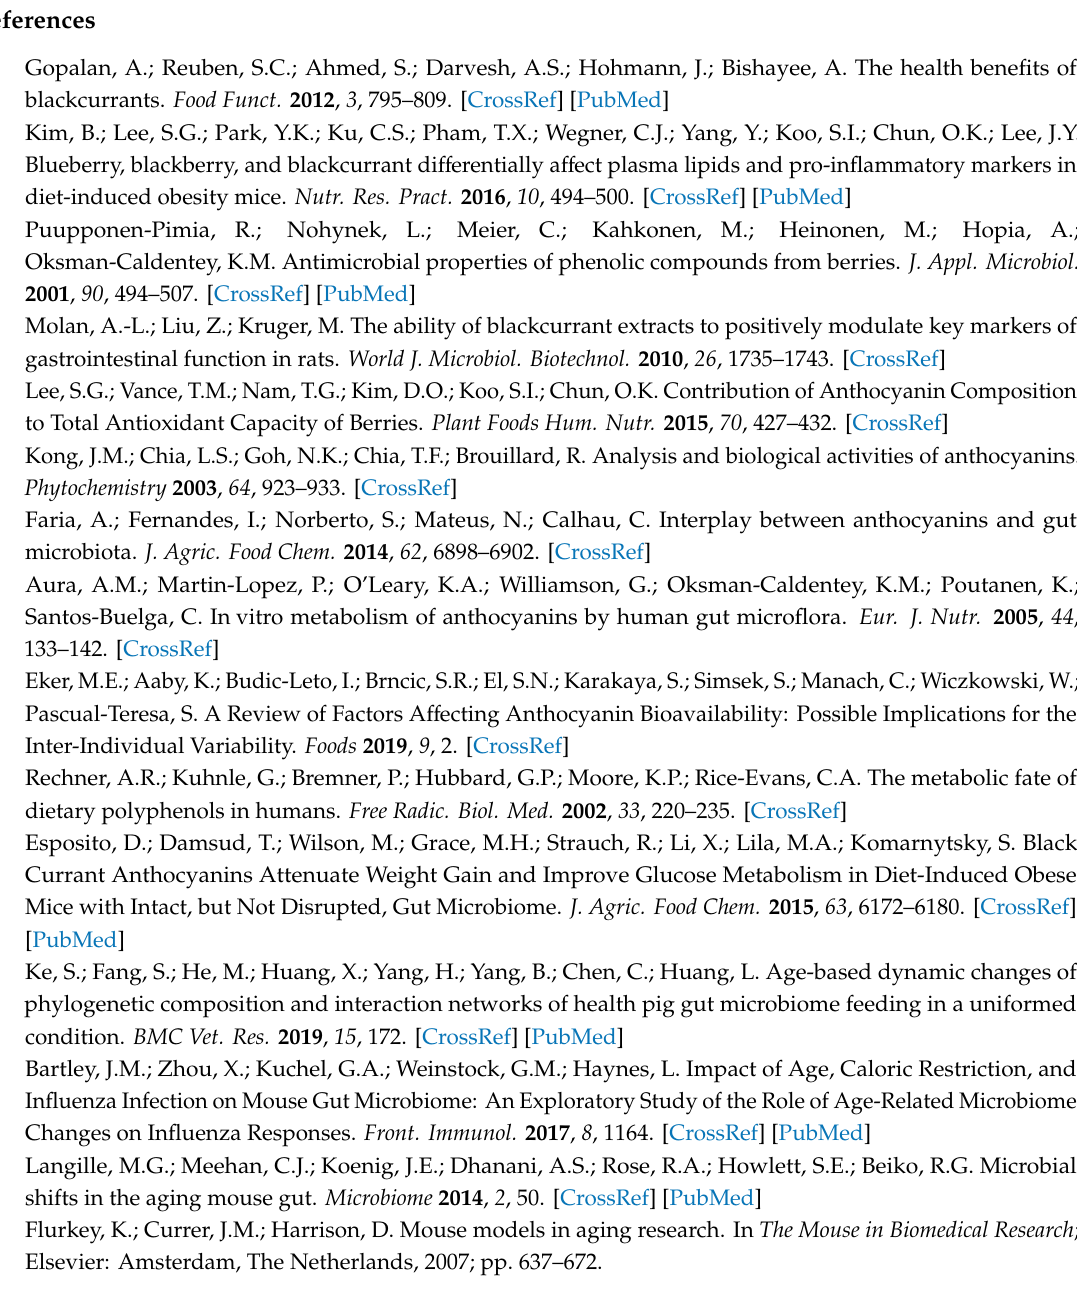
Figure S1: A heat map illustration with the OTUs about the interaction between BC and age on gut